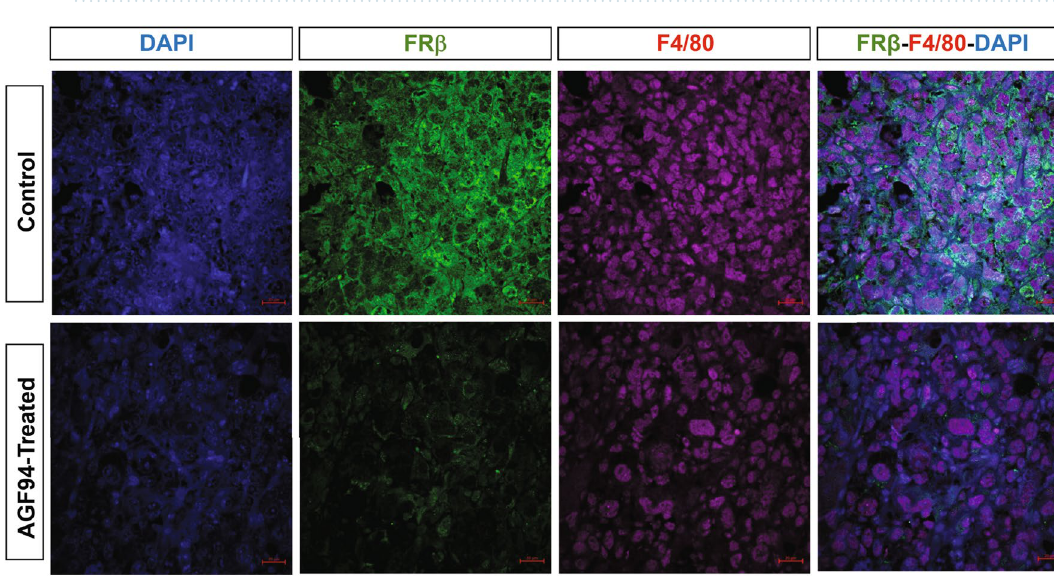
Figure 8. Immunofluorescence staining of FRβ-expressing tumor-associated macrophage population following treatment with AGF94. Slides were stained with FRβ (Genetex) with Alexa Fluor 488 secondary antibody and pan-Macrophage, F4/80, conjugated to APC-R700 (BD Biosciences). Images were acquired by confocal microscopy. Immunofluorescence staining is shown for representative tumor sections from control mice and mice treated with 4 doses of AGF94 . The scale is 20